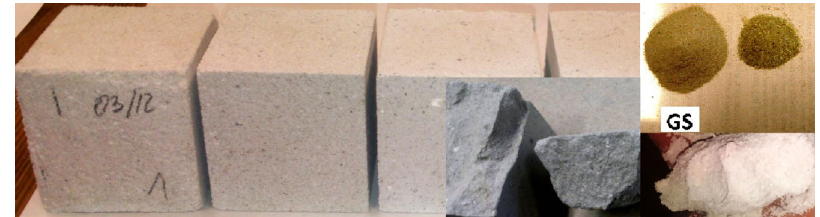
and a break through the structure of the brick modified by 90 wt% glass sand (GS).